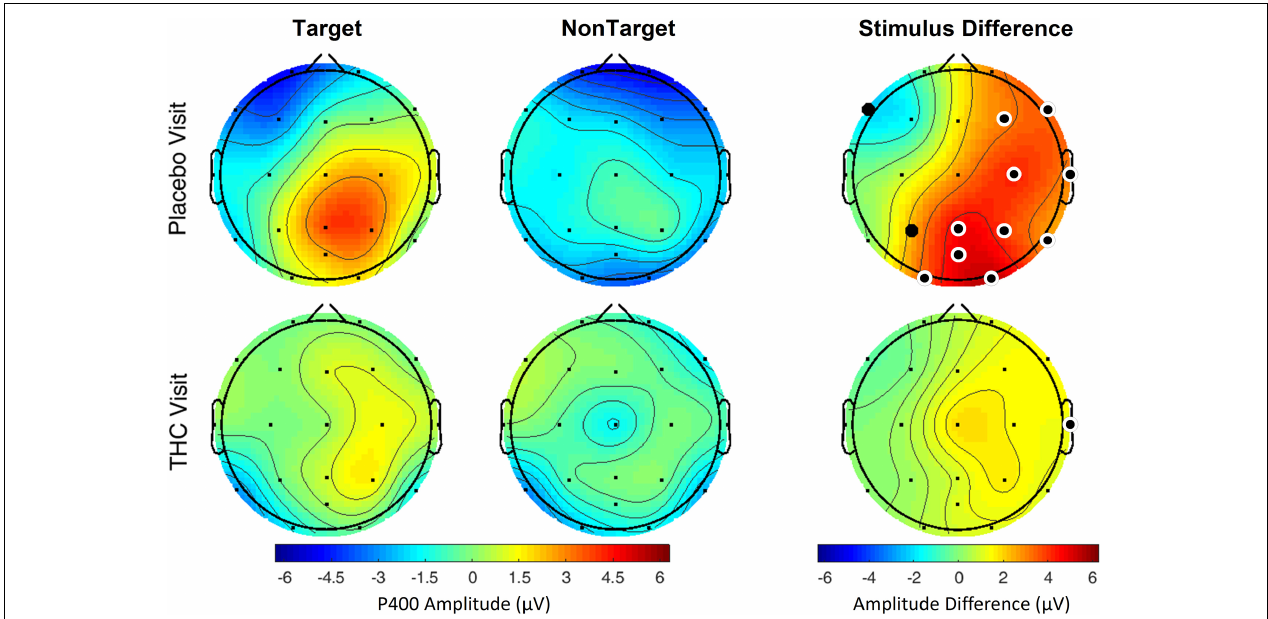
FIGURE 5 | Verbal memory scan, P400 by visit and stimulus. Robust amplitude differences between Target and NonTarget stimuli seen during the placebo visit were significantly reduced during THC visit. Filled black circles mark significant channels before FDR correction for multiple comparisons; white rings indicate channels that remained significant after FDR correction for multiple